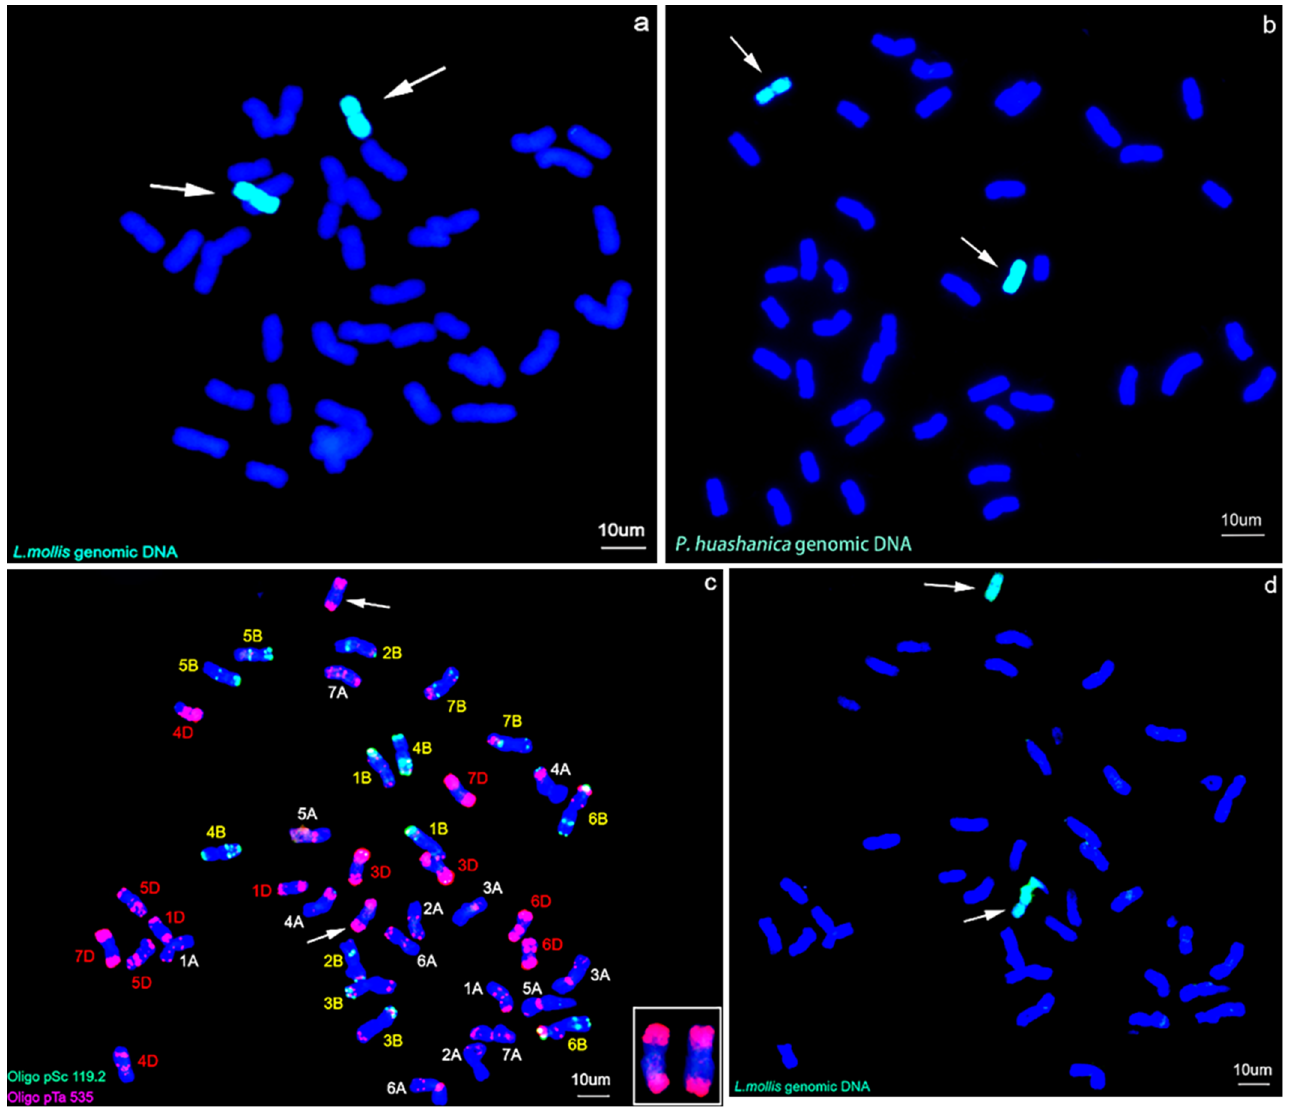
Figure 2. GISH and FISH-GISH analysis on 17DM48. The probes for GISH were L. mollis genomic DNA (green) and P. huashanica genomic DNA (green). ( a ) GISH detection of 17DM48 using L. mollis genomic DNA as probe (green). ( b ) GISH detection of 17DM48 using P. huashanica genomic DNA as probe (green). ( c ) FISH analysis of 17DM48. The probes were Oligo-pSc119.2 (green), and Oligo- pTa535 (red). ( d ) Sequential FISH-GISH analysis of 17DM48 by the probe of L. mollis genomic DNA. Chromosomes were counterstained using DAPI (blue). The arrows referred to alien chromosomes. Scale bar = 10 μ m.